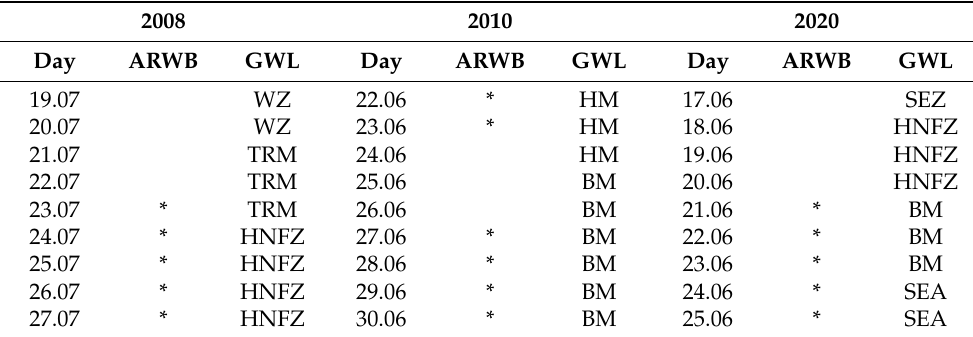
Table 2. Days with anticyclonic Rossby wave breaking (ARWB) and the type of circulation patterns (Großwetterlage—GWL) active during the days prior to the flood peaks in July 2008, June 2010 and June 2020. “*”—indicates the days when ARWB